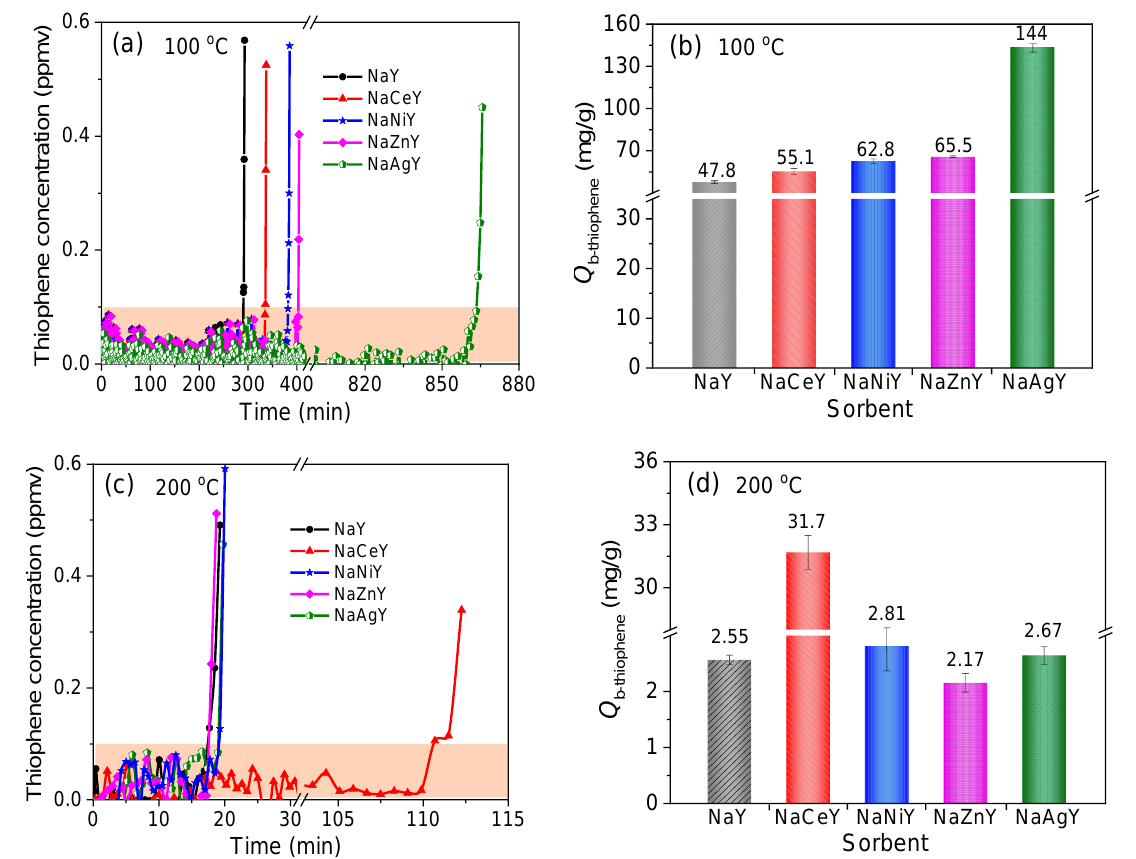
Figure 2. Thiophene breakthrough adsorption curves ( a , c ) and Q b-thiophene ( b , d ) of different Y zeolites at 100 °C and 200 °C in simulated COG.